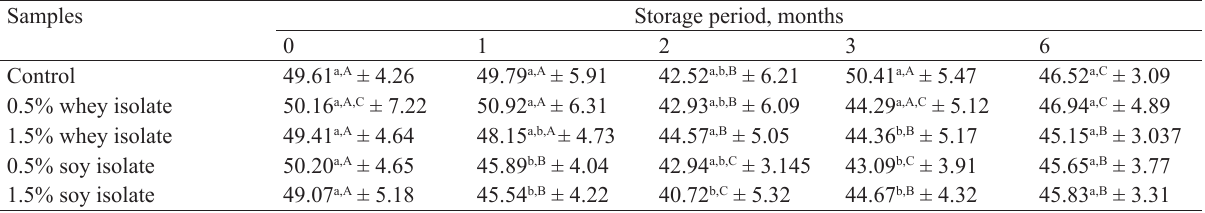
Table 4 L* values of sausages with protein isolates during storage (average ± SD)